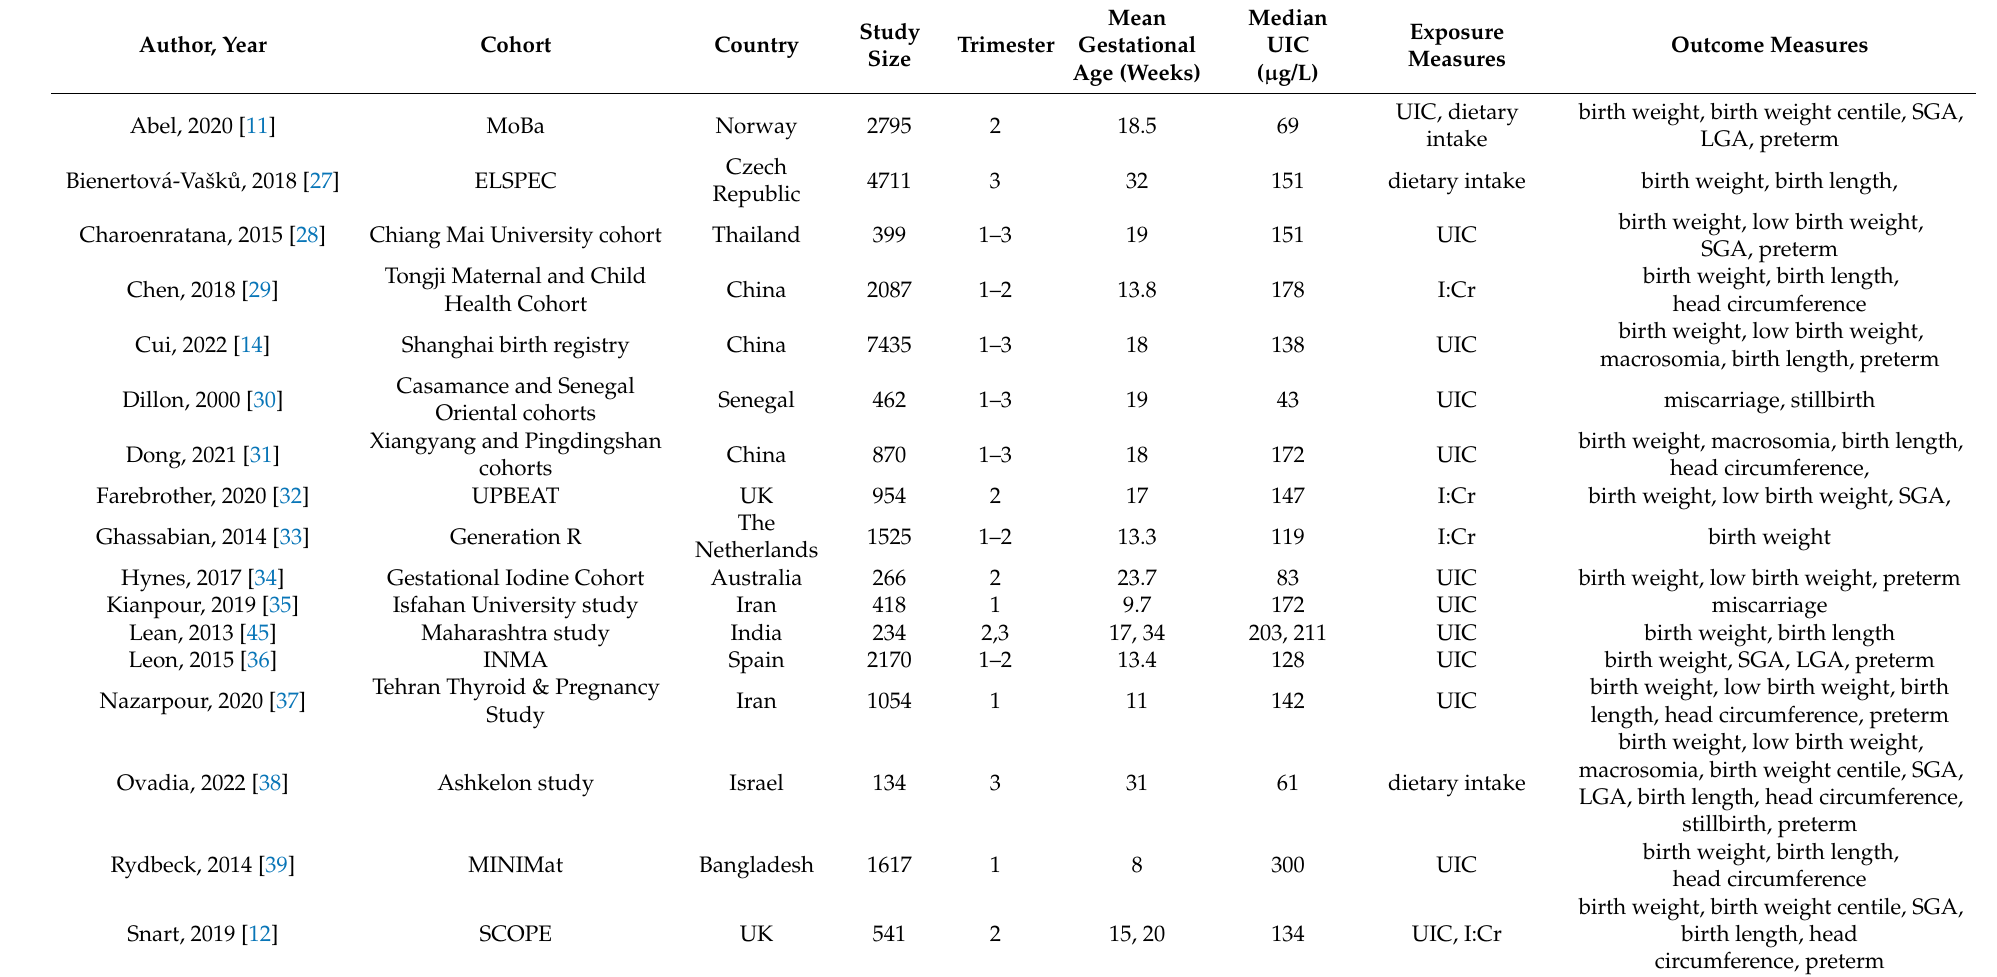
Table 1. Characteristics of included